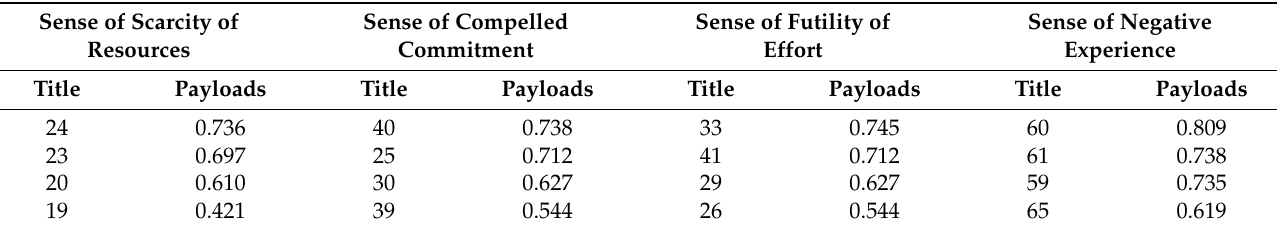
Table 2. Results of exploratory factor